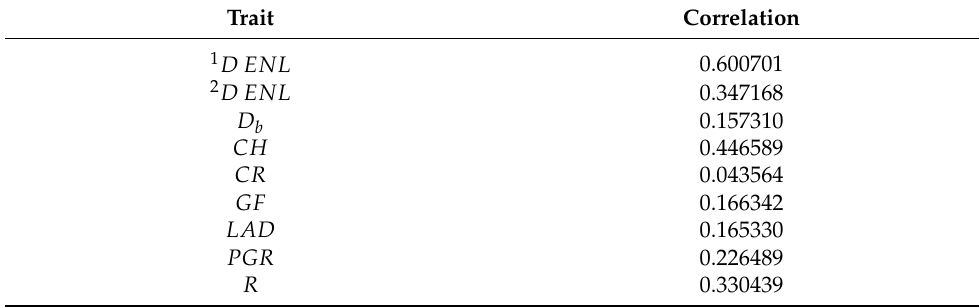
Figure A4. TLS correlation matrix at 0.5 m grid size. Table A1. Overview of correlation between ULS and TLS traits at 0.5 m grid size.